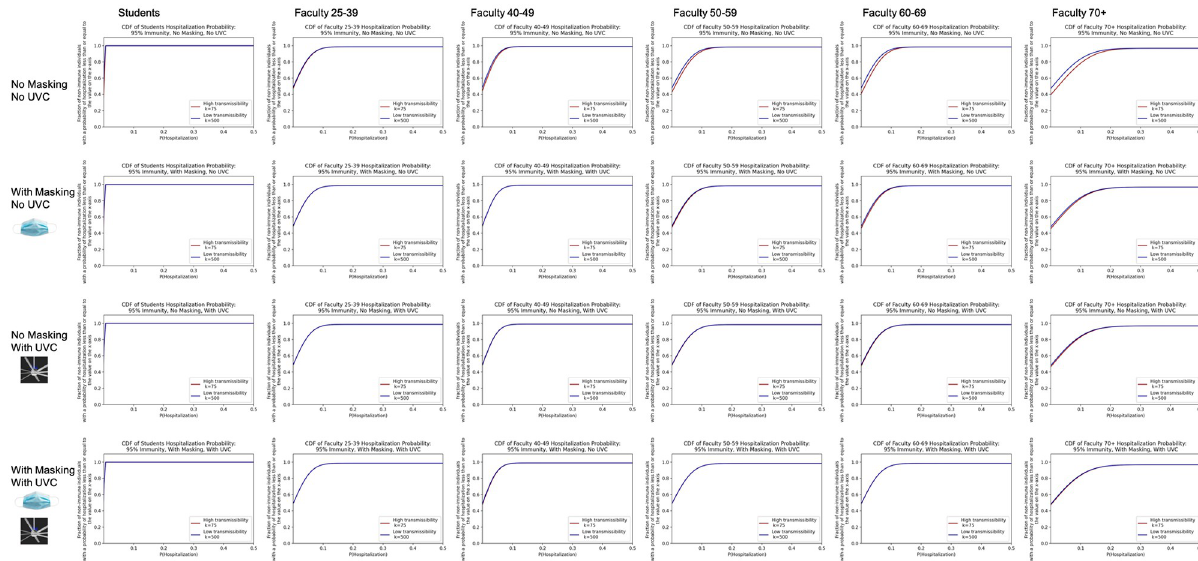
Fig 10. Cumulative density function for the probability of hospitalization by age group given 95% immunity. Note that all students are lumped together into one age group, assumed to be the 18–24 age group.